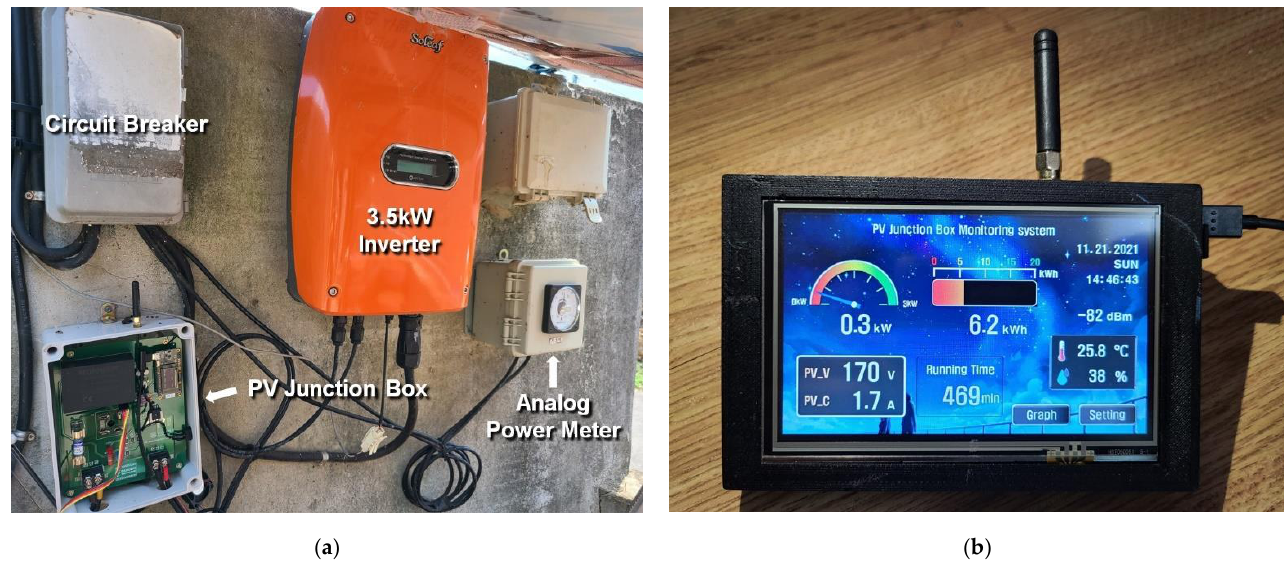
Figure 9. The experiment setup of proposed PV junction box system: ( a ) the proposed PV junction box monitoring system connected to a 3 kW PV system; ( b ) the GUI of the RX module that displays the PV junction box information.